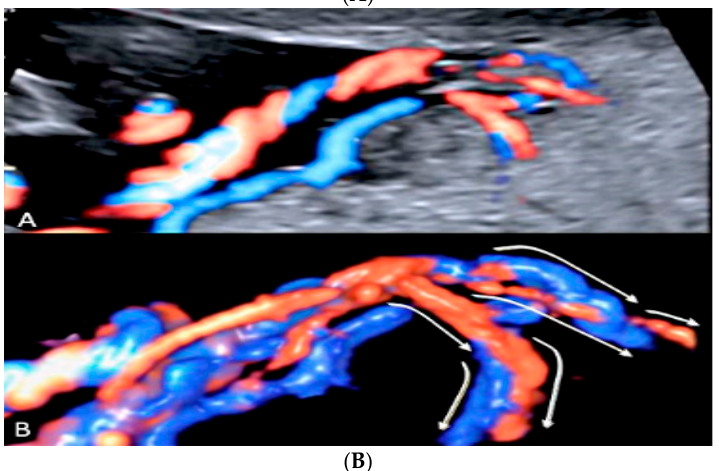
Figure 19. Pregnancy at 19 week’s gestation (same case of the previous figure). Two-dimensional color Doppler ultrasound ( A ) and four-dimensional color Doppler STIC volume ( B ) diagnosed velamentous cord insertion.